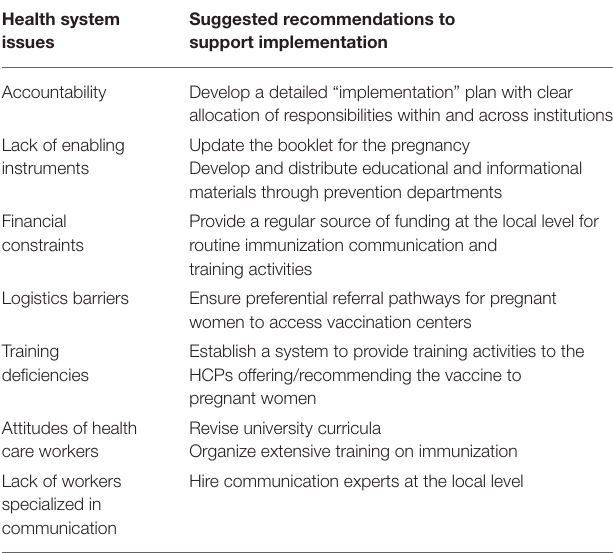
TABLE 2 | Issues and potential solutions to better support the implementation of maternal Tdap